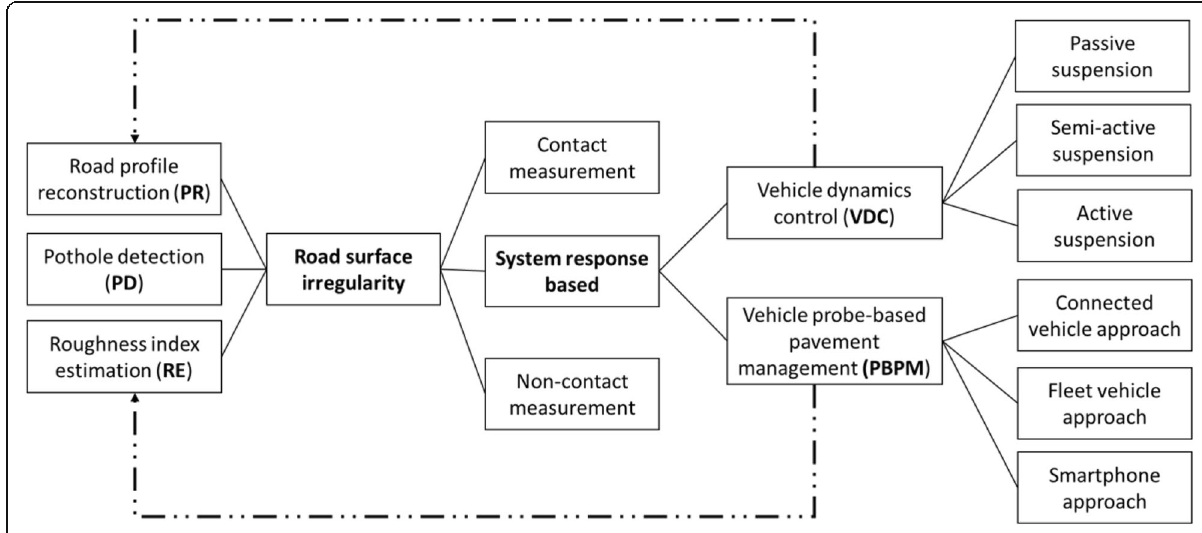
Fig. 2 Classification of different approaches to measure road surface irregularity under three main functions